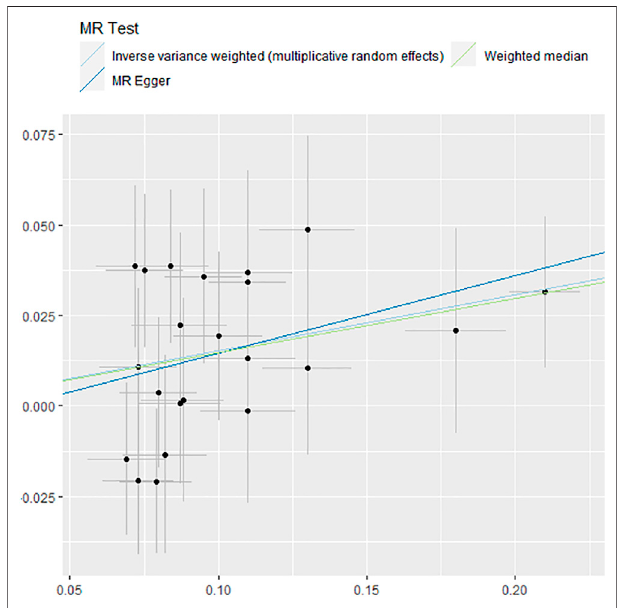
FIGURE 4 | Forest plot of causality between childhood obesity and LAS assessed by MR analysis. MR, Mendelian randomization.